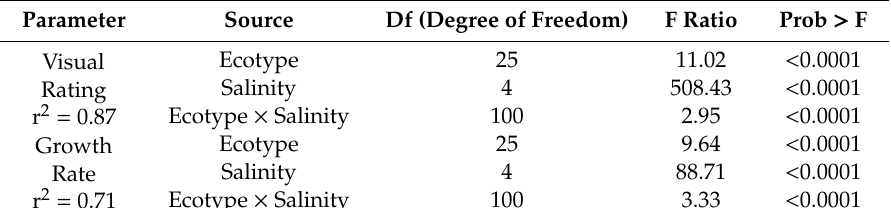
Table 1. Two-way analysis of variance showing the e ff ect of salinity concentration (2.0, 4.0, 10.0, 15.0, and 20.0 ppt), ecotype (24 di ff erent ecotypes) and their interaction on visual rating and growth rate of Vallisneria americana .